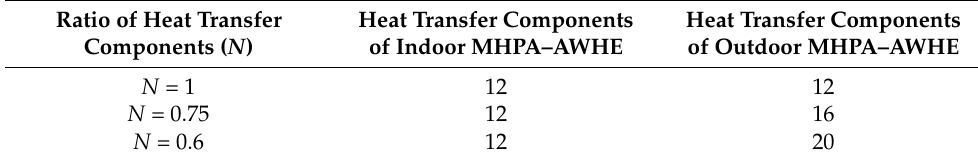
Figure 4. Indoor and Outdoor MHPA–AWHEs.